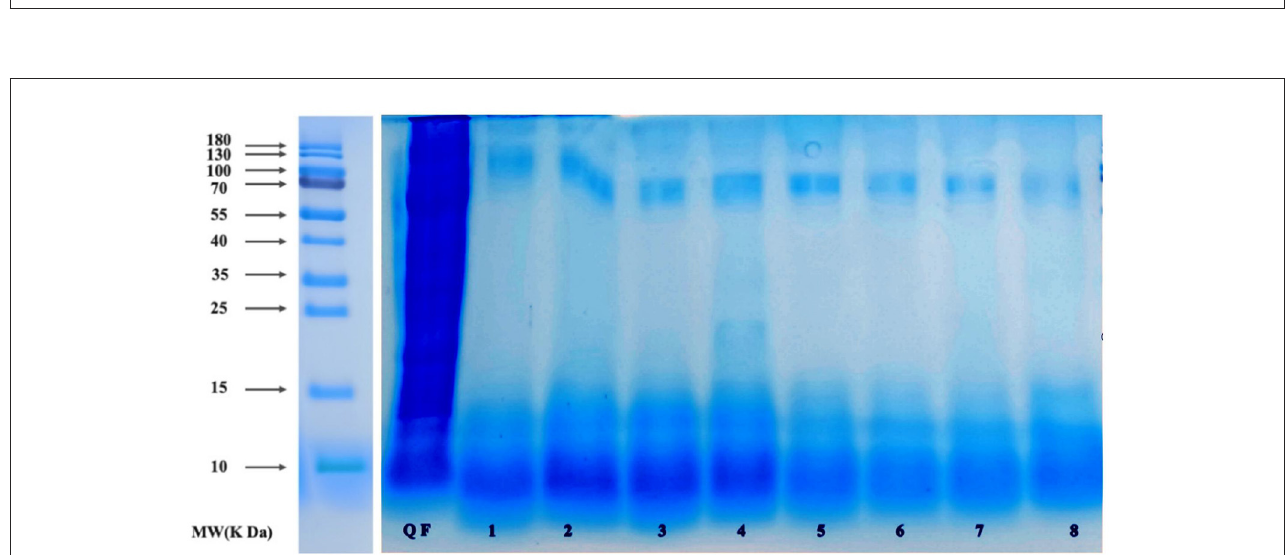
FIGURE4 SDS-PAGE pattern of QF after fermentation. 1: QF fermented by Bifi-dobacterium . 2: QF fermented by Lactobacillus casei . 3: QF fermented by Lactobacillus thermophilus . 4: QF fermented by Bacillus subtilis . 5: QF fermented by Lactobacillus fermentum . 6: QF fermented by Lactobacillus acidophilus . 7: QF fermented by Lactobacillus paracasei . 8: QF fermented by Lactococcus lactis subsp